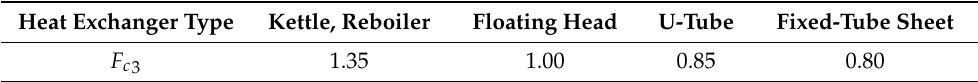
Table A3. Correction factors for heat exchangers.